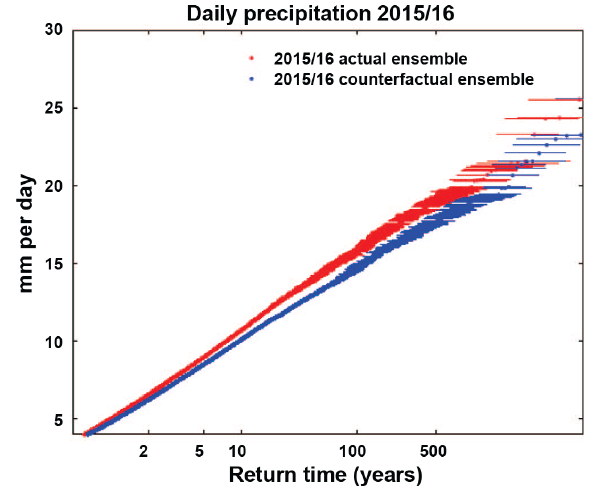
Figure 7. Probability plot for the maximum of winter (DJF) daily precipitation averaged over the northern UK, 54–57 ◦ N, 6 ◦ W–2 ◦ E. Red indicates the probability of daily mean precipitation under ob- served climate conditions, blue the counterfactual simulations with- out anthropogenic climate change. See Otto et al. (2018a) for more